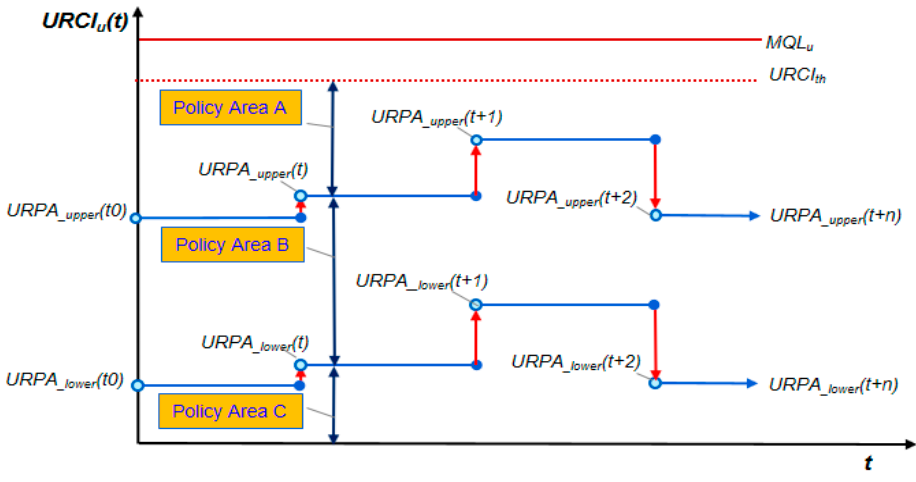
Figure 6. UAV routing policy area (URPA) example.